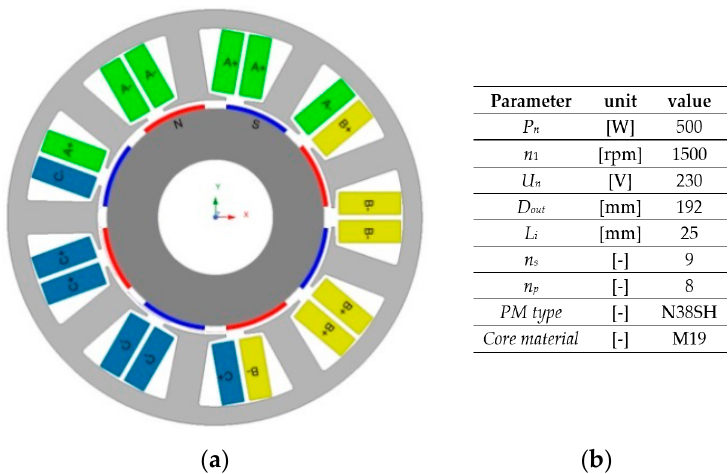
Figure 6. Structure ( a ) and major parameters ( b ) of studied PMSM (second structure of n s / n p equal to 9/8).